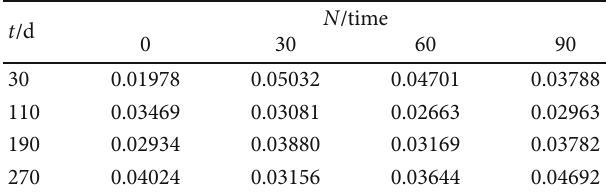
ff erent freeze-thaw cycles 0 of di